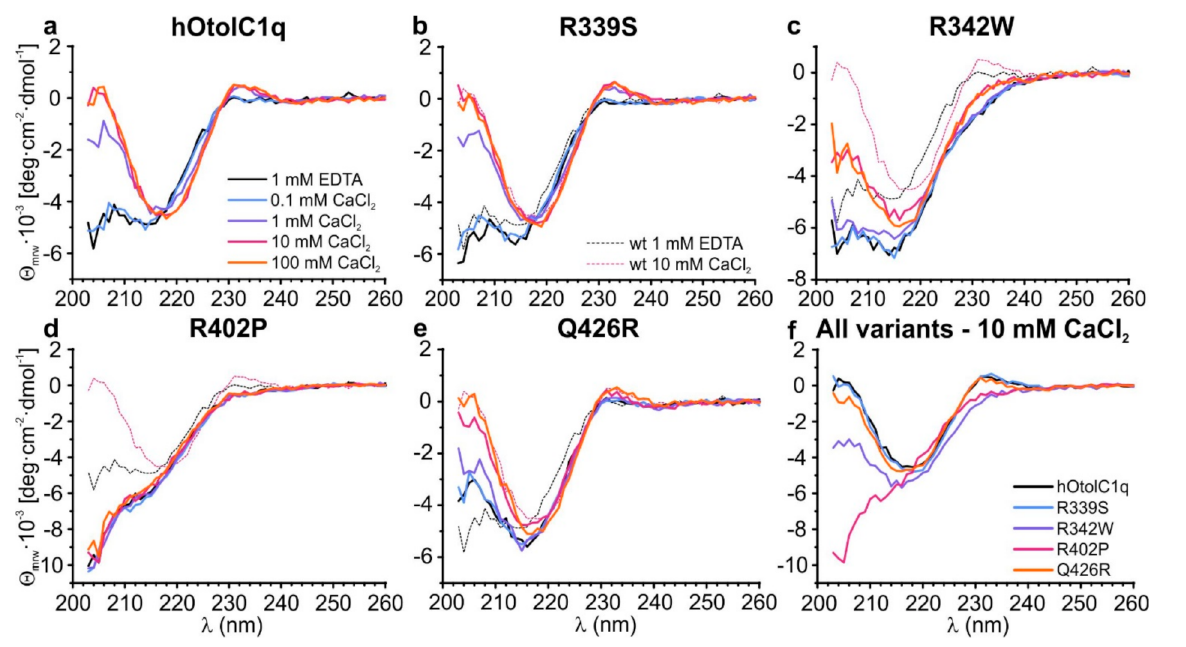
Figure 3. Changes in the secondary structure of ( a ) hOtolC1q introduced by the mutations: ( b ) R339S, ( c ) R342W, ( d ) R402P and ( e ) Q426R. Circular dichroism spectra were collected for 0.20 mg/mL proteins in the absence and in the presence of 0.1–100 mM Ca 2+ . The panel ( f ) contains a comparison of the spectra for all tested variants at 10 mM Ca 2+